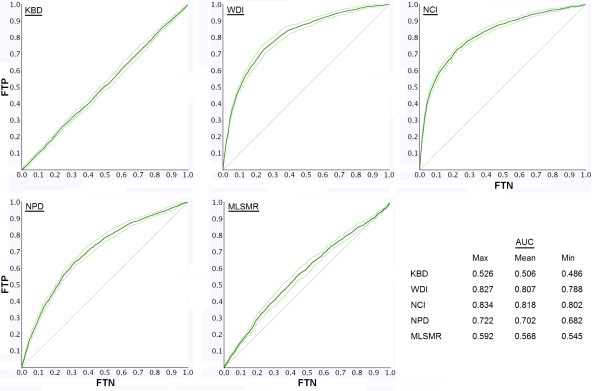
ROC plots of five databases: KBD, WDI, NCI, NPD, and MLSMR. The Y-axis indicates the fraction of true positives (FTP) and the X-axis indicates the fraction of true negatives (FTN). The table in the lower right shows the calculated maximum (upper light green line), mean (dark green line) and minimum (lower light green line) AUC values of the ROC plots based on the 10 different calculations for each database. AUC values closer to random (0.50) signify more kinase-likeness, meaning that kinase-likeness score is unable to distinguish the 1% of kinase active compounds that were mixed in from the other compounds in a given database. This indicates that those compounds have physicochemical properties that are similar to kinase active compounds. A diagonal reference line (area under the curve = 0.50) defines points where kinases are not discernible from the test database compounds. As validation, randomly selected kinase compounds were mixed in with the KBD (upper left plot) and an average AUC of 0.5 was observed.